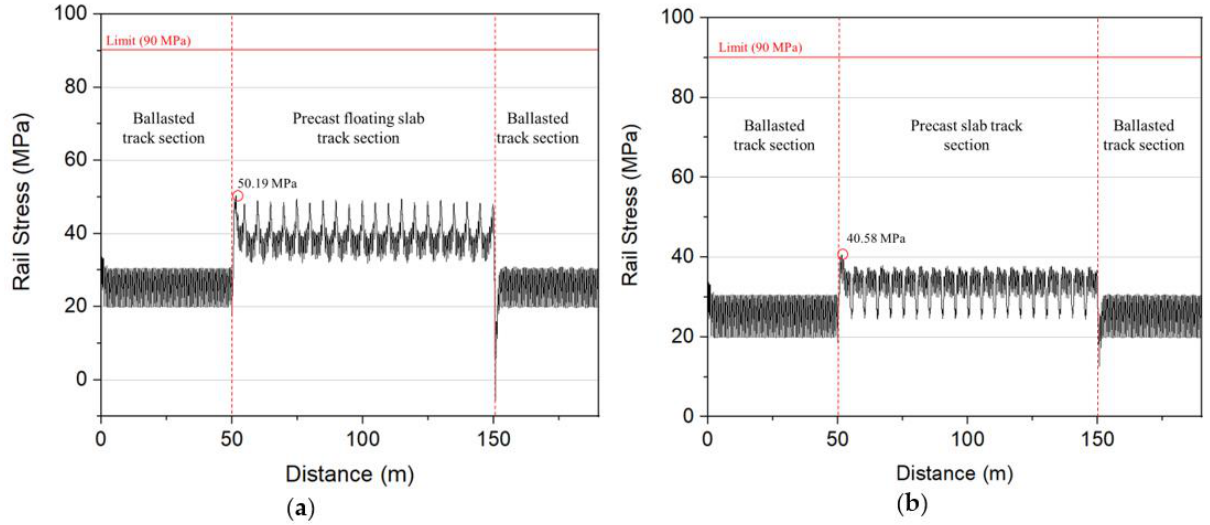
Figure 10. Rail bottom results: ( a ) Type I, ( b ) Type